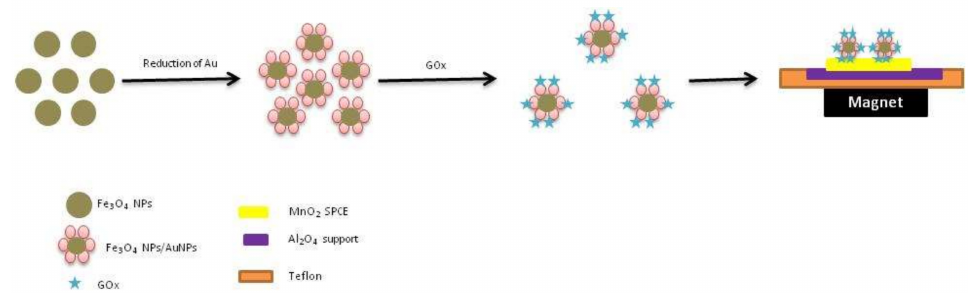
Figure 5. Schematic representation of flow-injection-based amperometric glucose biosensor.